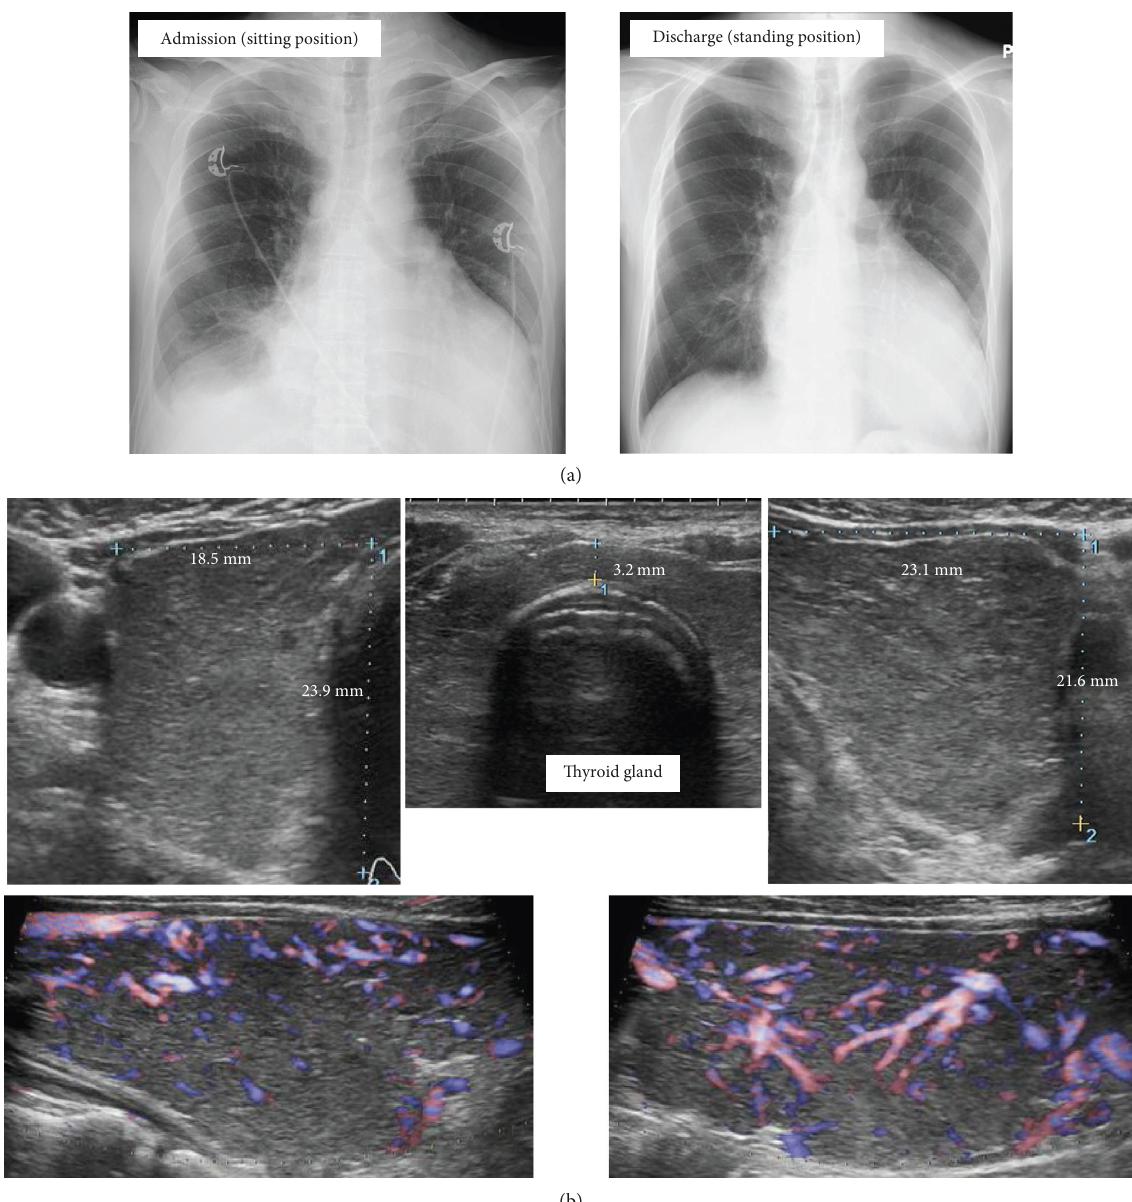
Figure 1: Imaging findings at first admission. (a) Chest X-ray on admission and discharge. (b) An ultrasonogram showing enlargement and increased blood flow of the thyroid